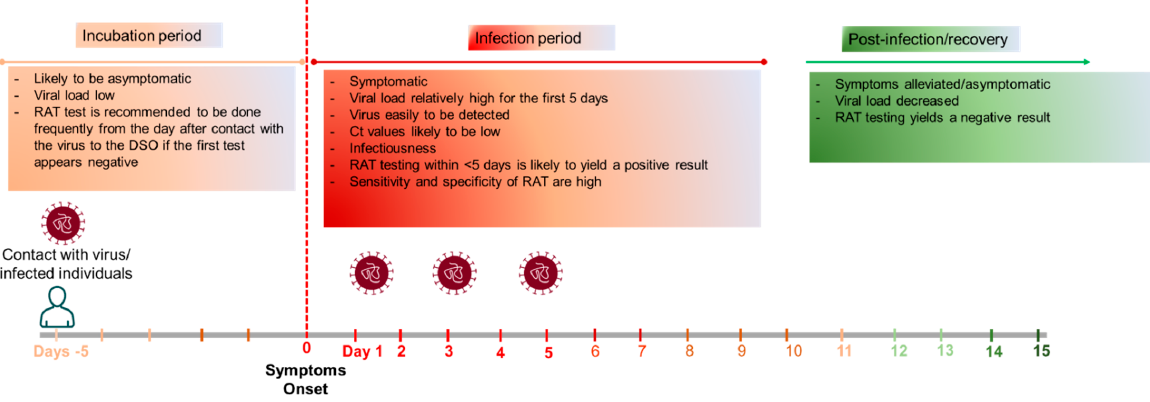
Figure 2. Disease progression of COVID-19 and its influence on RAT performance. The progression of COVID-19 disease is divided into three main periods. In the incubation period (first day of contact with the virus to the day of symptom onset), the viral accumulation is relatively low, and rapid antigen testing within this period is likely to yield a negative result; thus, the test is recommended to be taken frequently. A RAT conducted within 5 days of symptom onset is likely to return a positive result. The performance (sensitivity and specificity) of the RAT is at its highest during this infection period. Eleven days after symptom onset (DSO), the symptoms are likely to become milder to asymptomatic, the viral load decreases, and the RAT during this period will likely return a negative result. If the test remains positive, another test is recommended to be conducted frequently for a certain period (e.g., every two days) until the result is negative.